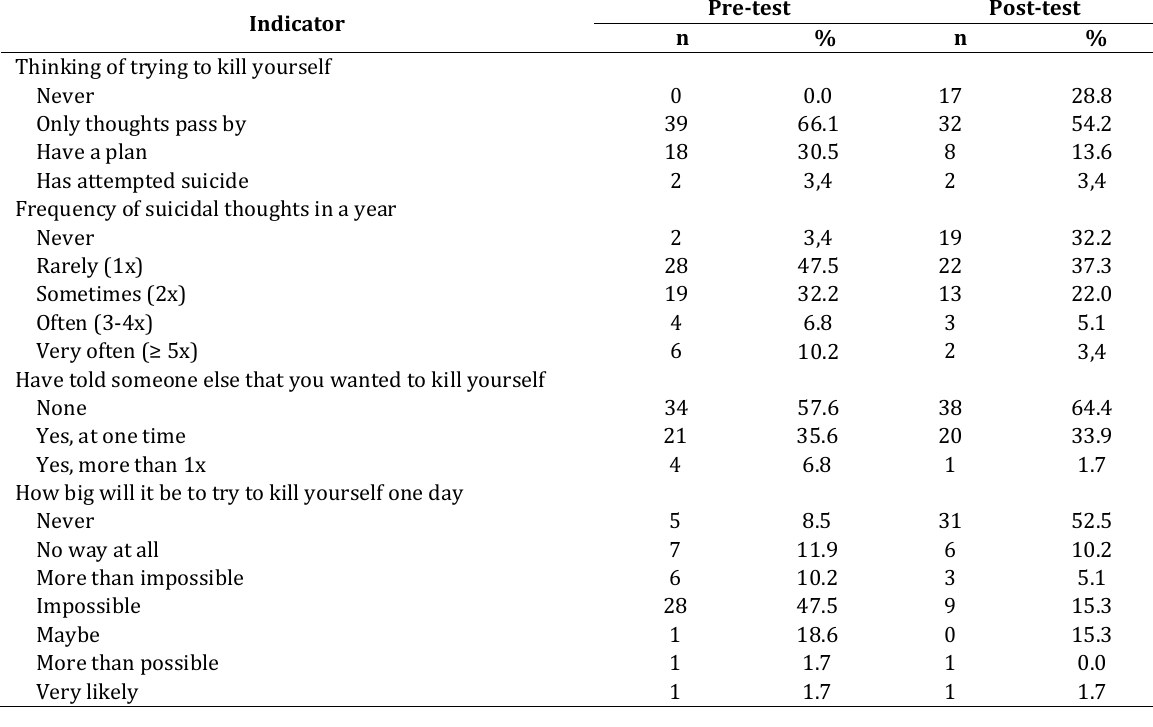
Table 2. The Pre and Post-Test Suicide Risk Scores Indicator